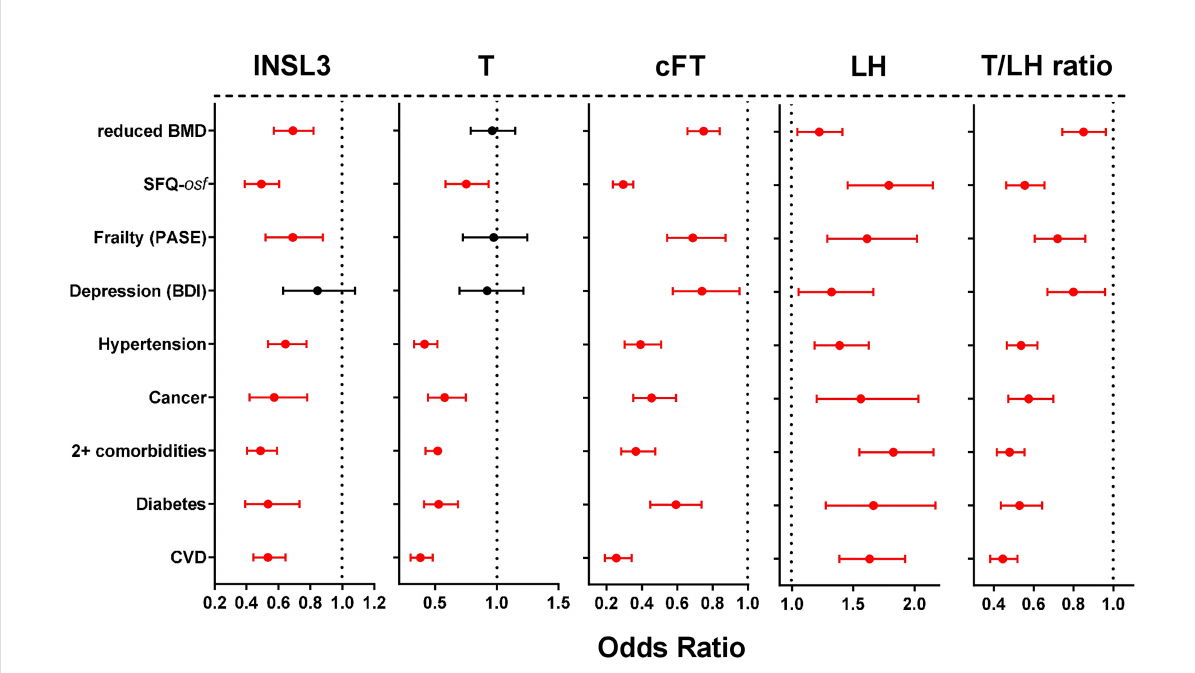
FIGURE 2 Odds ratios (OR; with 95% con fi dence intervals) calculated from simple binomial logistic regressions of the indicated binomial categorical variables representing different phase 2 morbidities (present vs absent), as indicated on the Y axis, against the various phase 2 predictors: INSL3, T, cFT, LH, or the T/LH ratio as continuous variables. Signi fi cant OR are indicated in red. Bone mineral density (BMD) is here expressed as a binomial categorical variable with the lower 50 th percentile represented as 1, and the higher 50 th percentile represented as 0. Similarly, overall sexual function (SFQ- osf ) is also expressed as a binomial categorical variable with the lower 50th percentile represented as 1, and the higher 50th percentile represented as